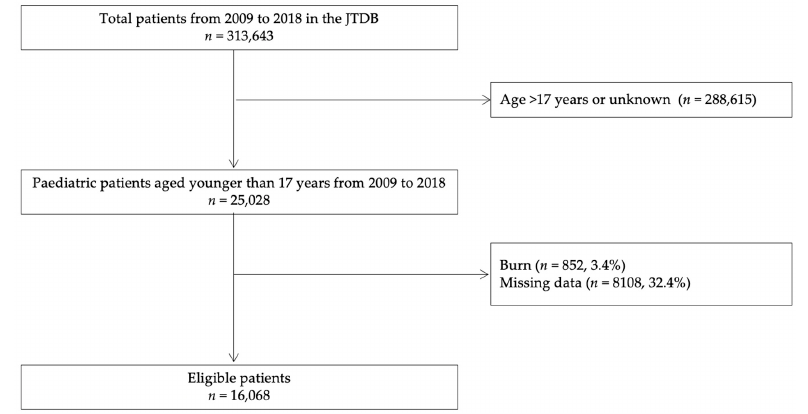
Figure 1. Flow diagram of study patient disposition. JTDB, Japanese Trauma Data Bank.